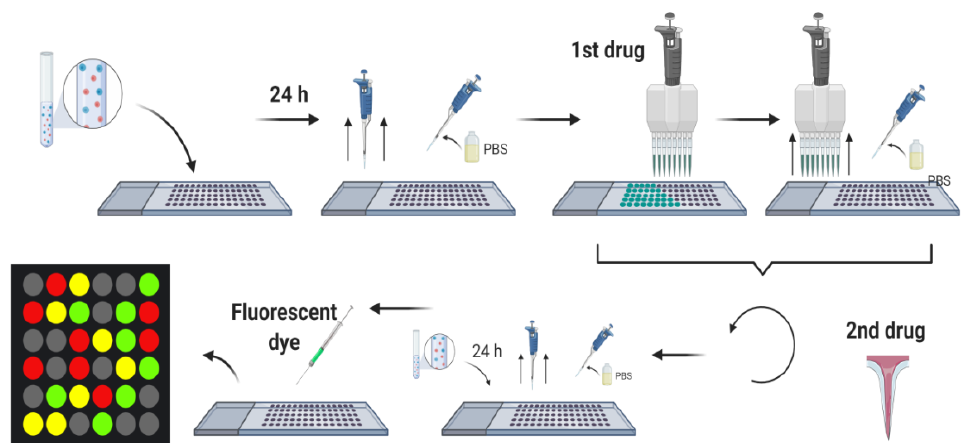
Figure 10. Schematic of combinatory microarray screening performance used by Du et al. where droplets formed in a Nanowell chip by the interaction of cell suspension and oil are exposed for changes in media and schedules dosage-dependent drug assays to perform stimulation–response studies based on the fluorometric analysis in a high-throughput manner. (Created with